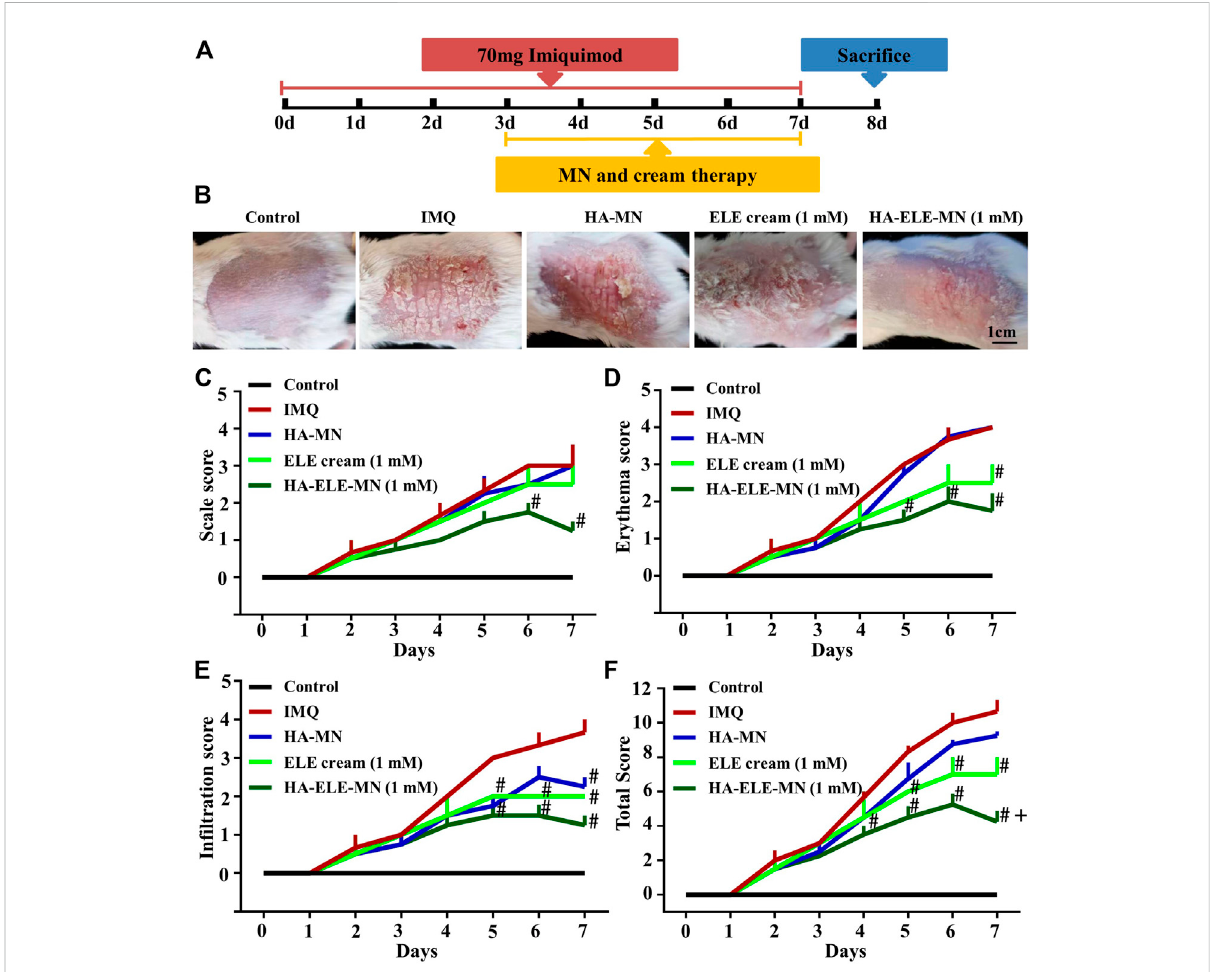
Mitigation of IMQ-induced psoriasis after exposure to HA-ELE-MN (1mM). (A) Schematic illustration of HA-ELE-MN (1mM) for the treatment of IMQ-induced psoriasis. (B) Representative photographs captured on day 7 (treated with IMQ for 7 days and exposed to ELE cream (1mM), HA-MN, and HA-ELE-MN (1mM) for 4 days). (C – E) PASI scores of scales, erythema, and in fi ltration. (F) Total PASI scores by pooling scales, erythema, and in fi ltration together. # p < 0.05 versus IMQ, + p < 0.05 versus ELE cream (1mM). Error bars indicate SEM ( n =